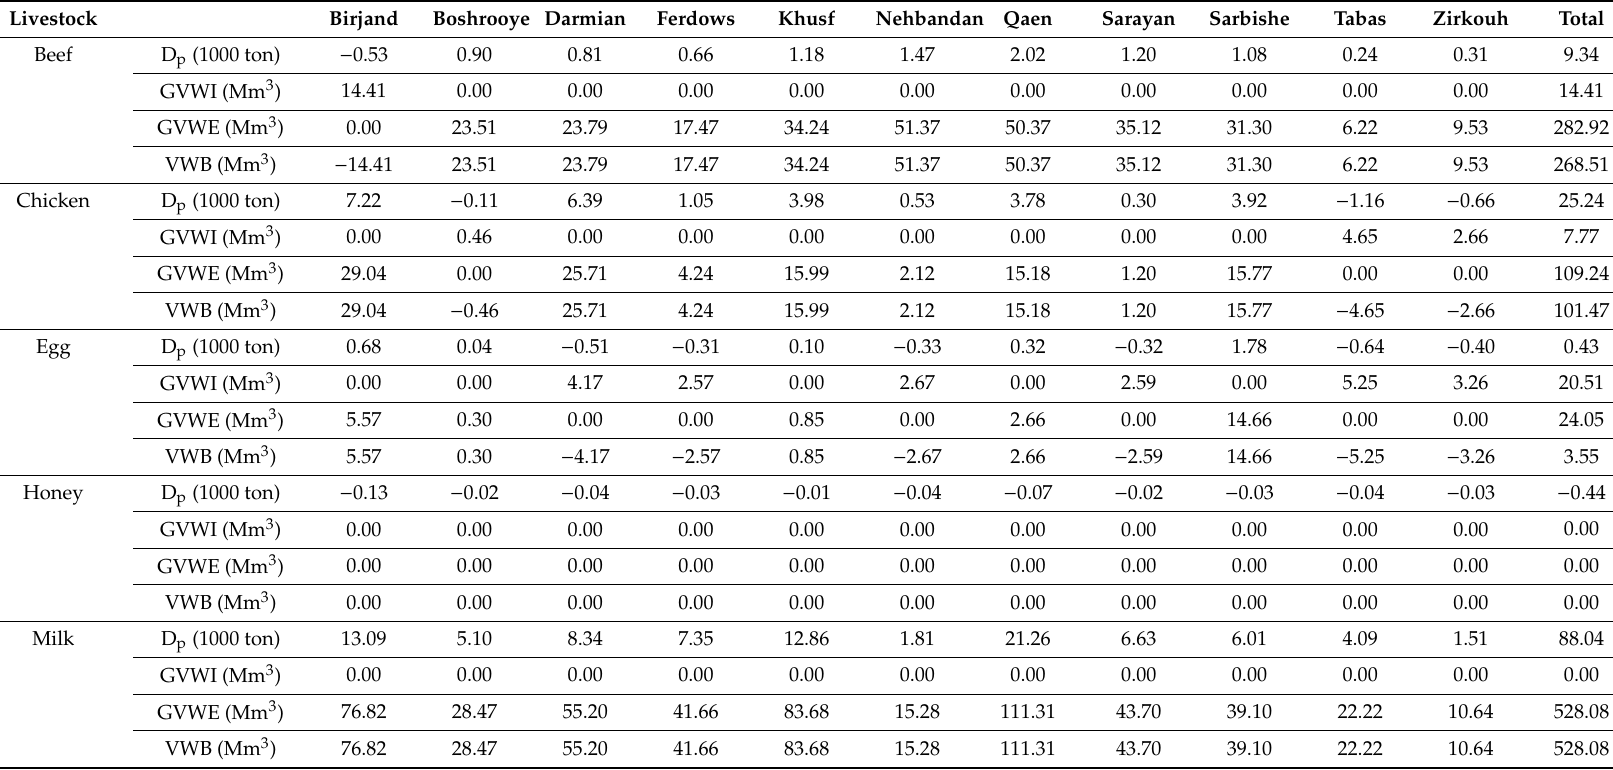
Table 5. Comparison of 10-year average Gross Virtual Water Import (GVWI) and Gross Virtual Water Export (GVWE) of 11 counties in livestock.